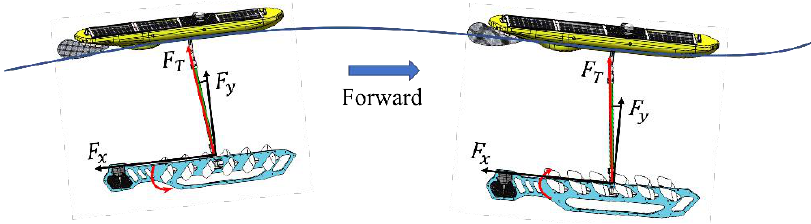
Figure 1. Umbilical cable inclination angle of the wave